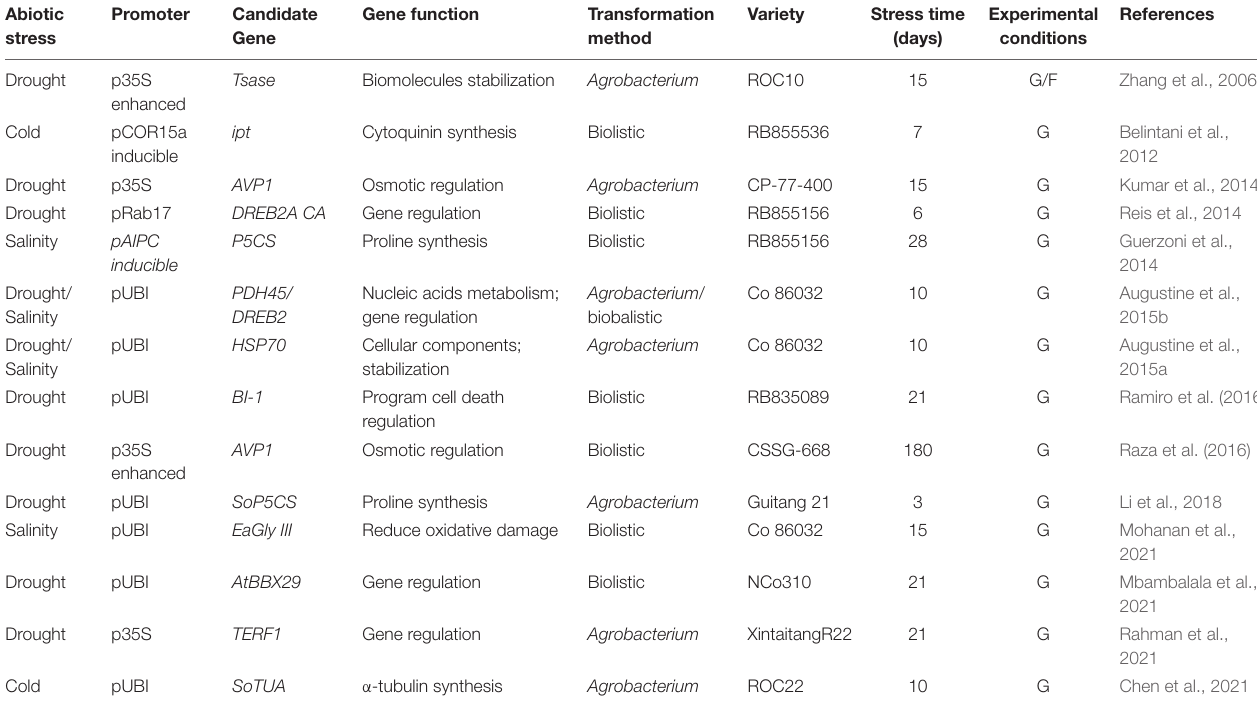
TABLE 5 | Abiotic stress tolerance studies in transgenic